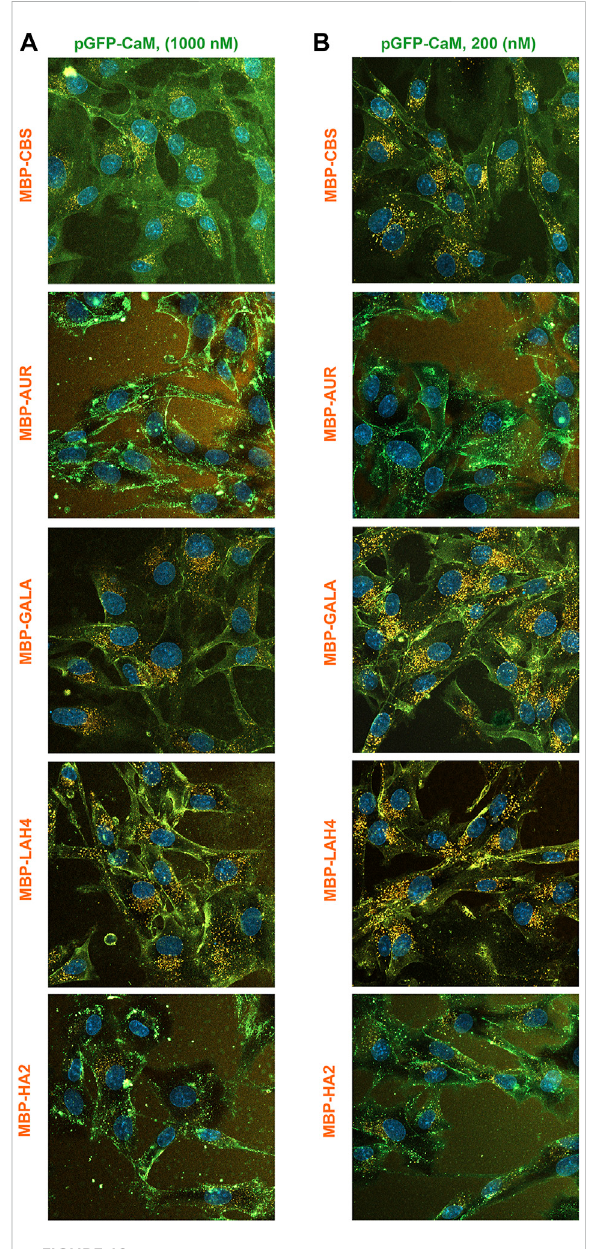
FIGURE 12 Colocalization of MBP-EP-CBS cargos and pGFP-CaM during comparison of the internalization of the fi ve MBP-EP-CBS cargos at two concentrations. Simultaneous internalization of the fi ve 550-labeled MBP-EP-CBS cargos with equimolar pGFP- CaM at complex concentrations of (A) 1000 nM or (B) 200 nM. Equimolar adaptor/cargo complexes were internalized in growth media containing NucBlue and imaged with the complex present between 40 – 60